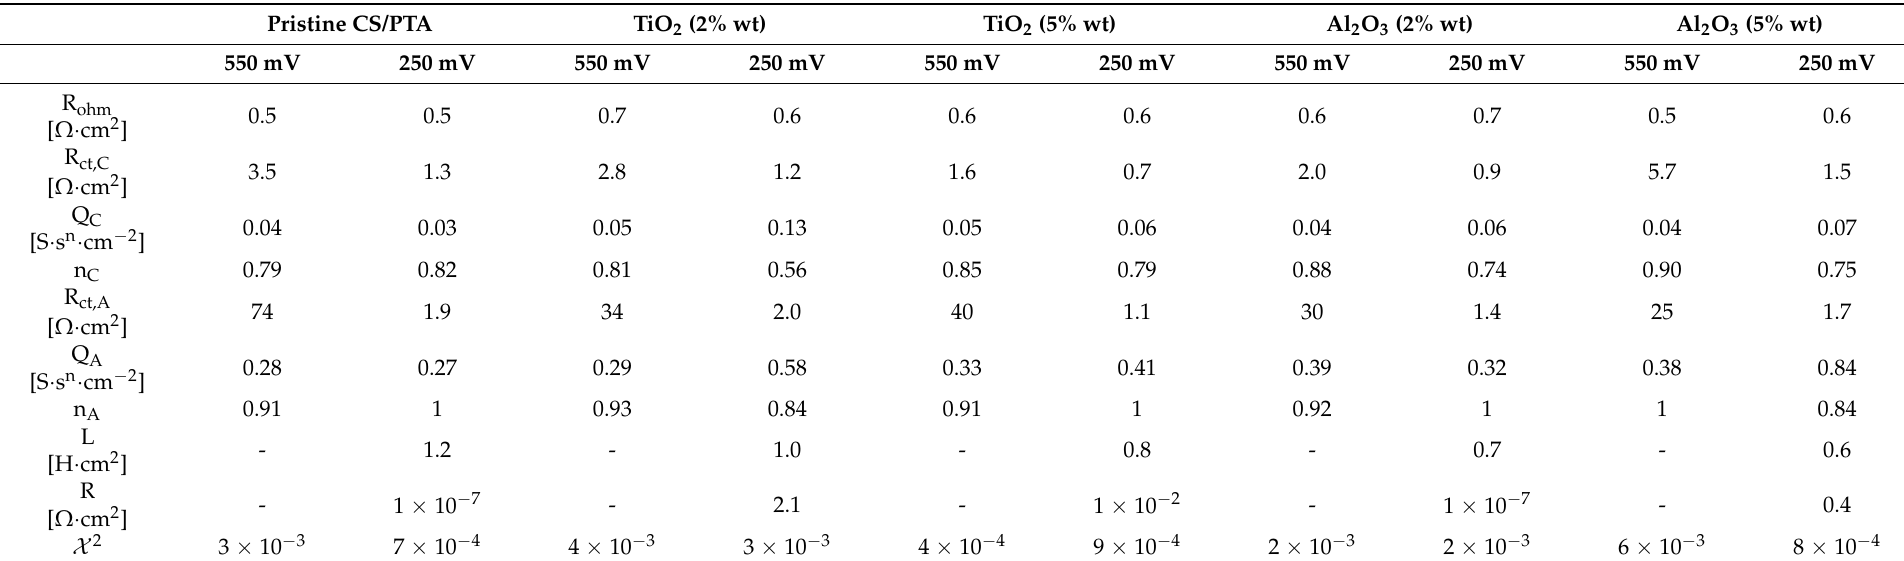
Table 1. Fitting parameters of EIS spectra recorded for all the investigated membranes. EECs: inset of Figure 10a,d. Pristine